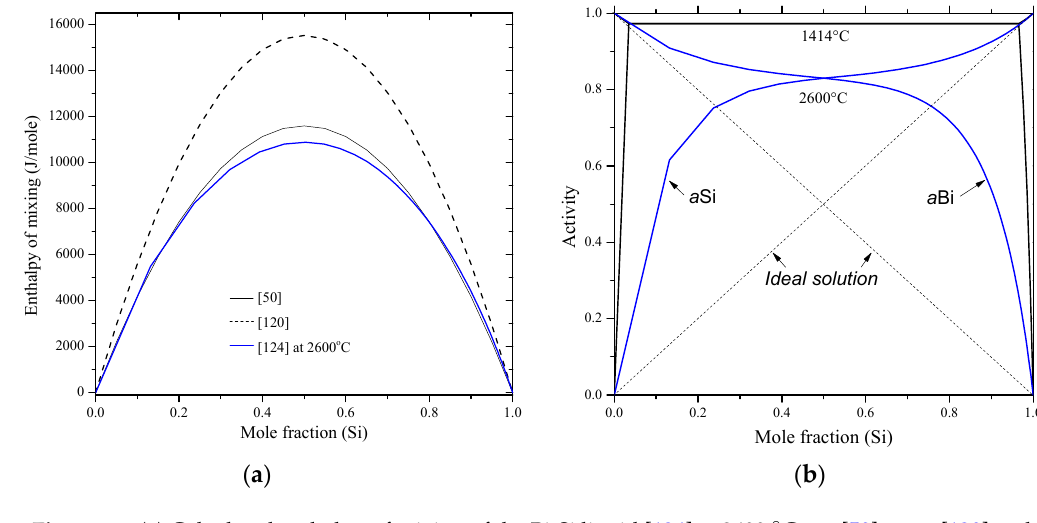
Figure 17. ( a ) Calculated enthalpy of mixing of the Bi-Si liquid [124] at 2600 °C; ― : [50]; ----: [120] and ( b ) calculated activity of Bi and Si in the Bi-Si liquid at 1414 °C and 2600 °C [124]. Table 9. Thermodynamic parameters of the liquid phase in Bi-Si system. Phase Excess Gibbs Energy Parameter (J/Mole) Ref. Liquid 0 L liq = 46 370 + 2.26 T [120]